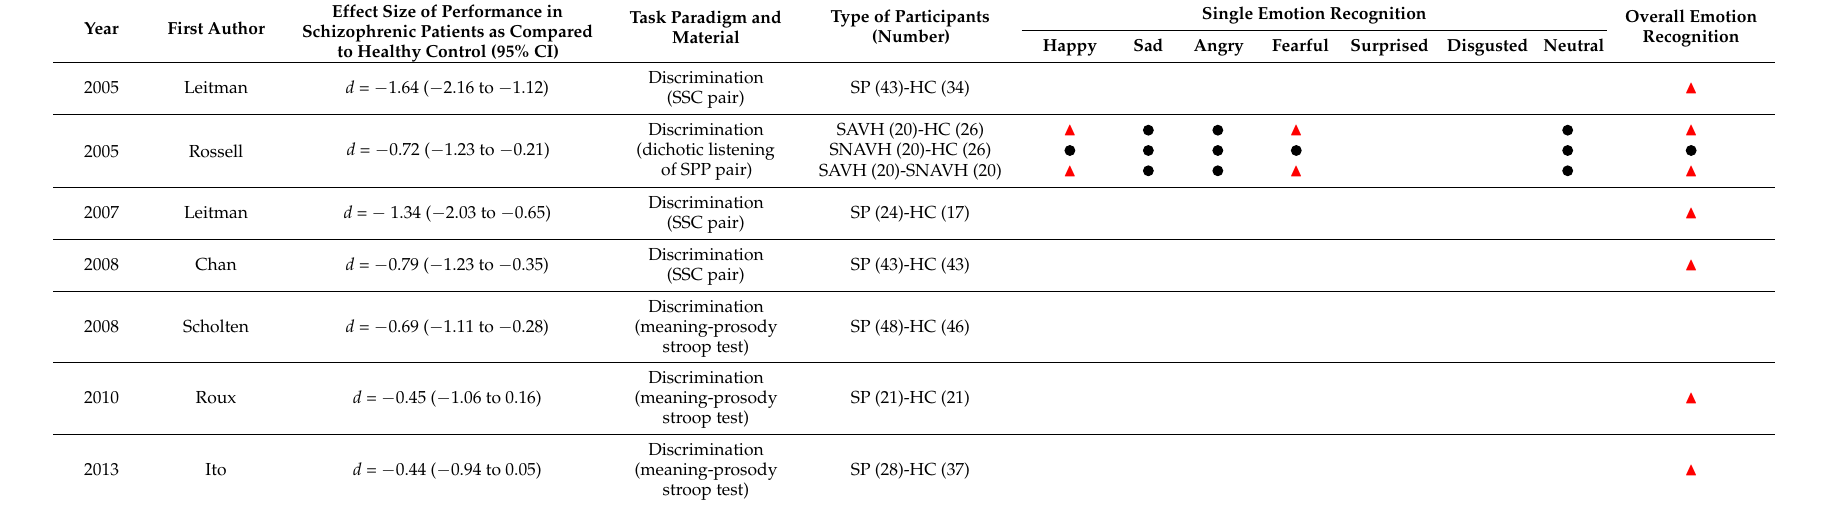
Table 3. EPP performance of participant groups (Discrimination